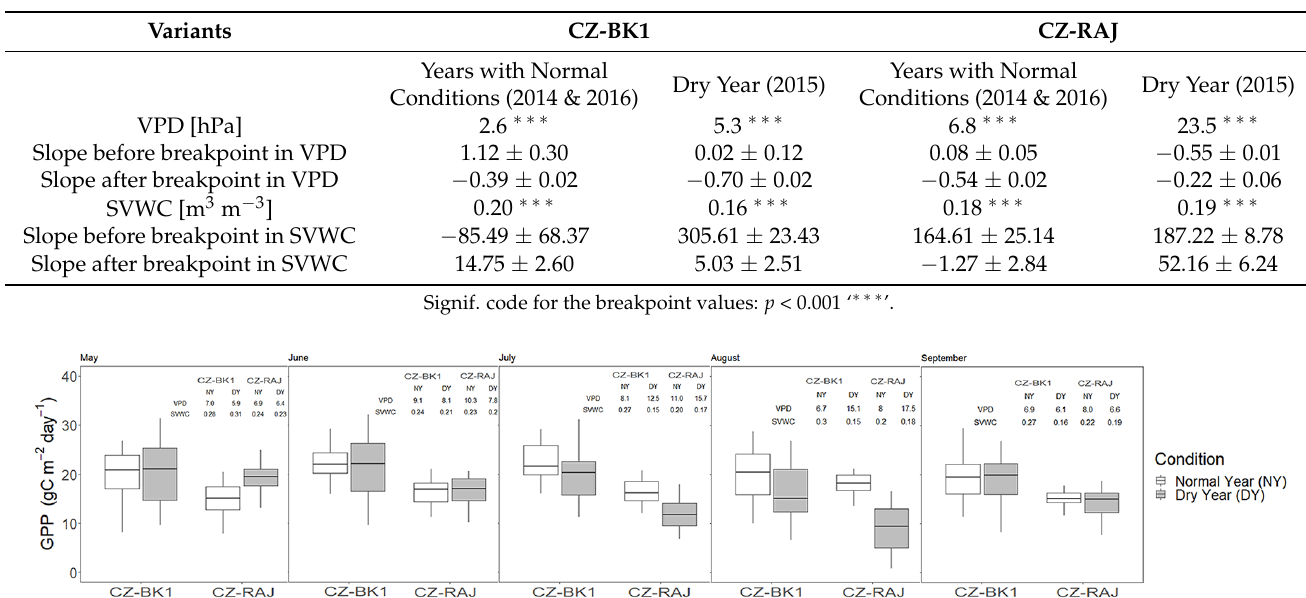
Table 7. Breakpoints and Slopes from the piecewise regression of the light response curve residuals to vapour pressure deficit (VPD) and soil volumetric water content (SVWC) for the period of May–September.